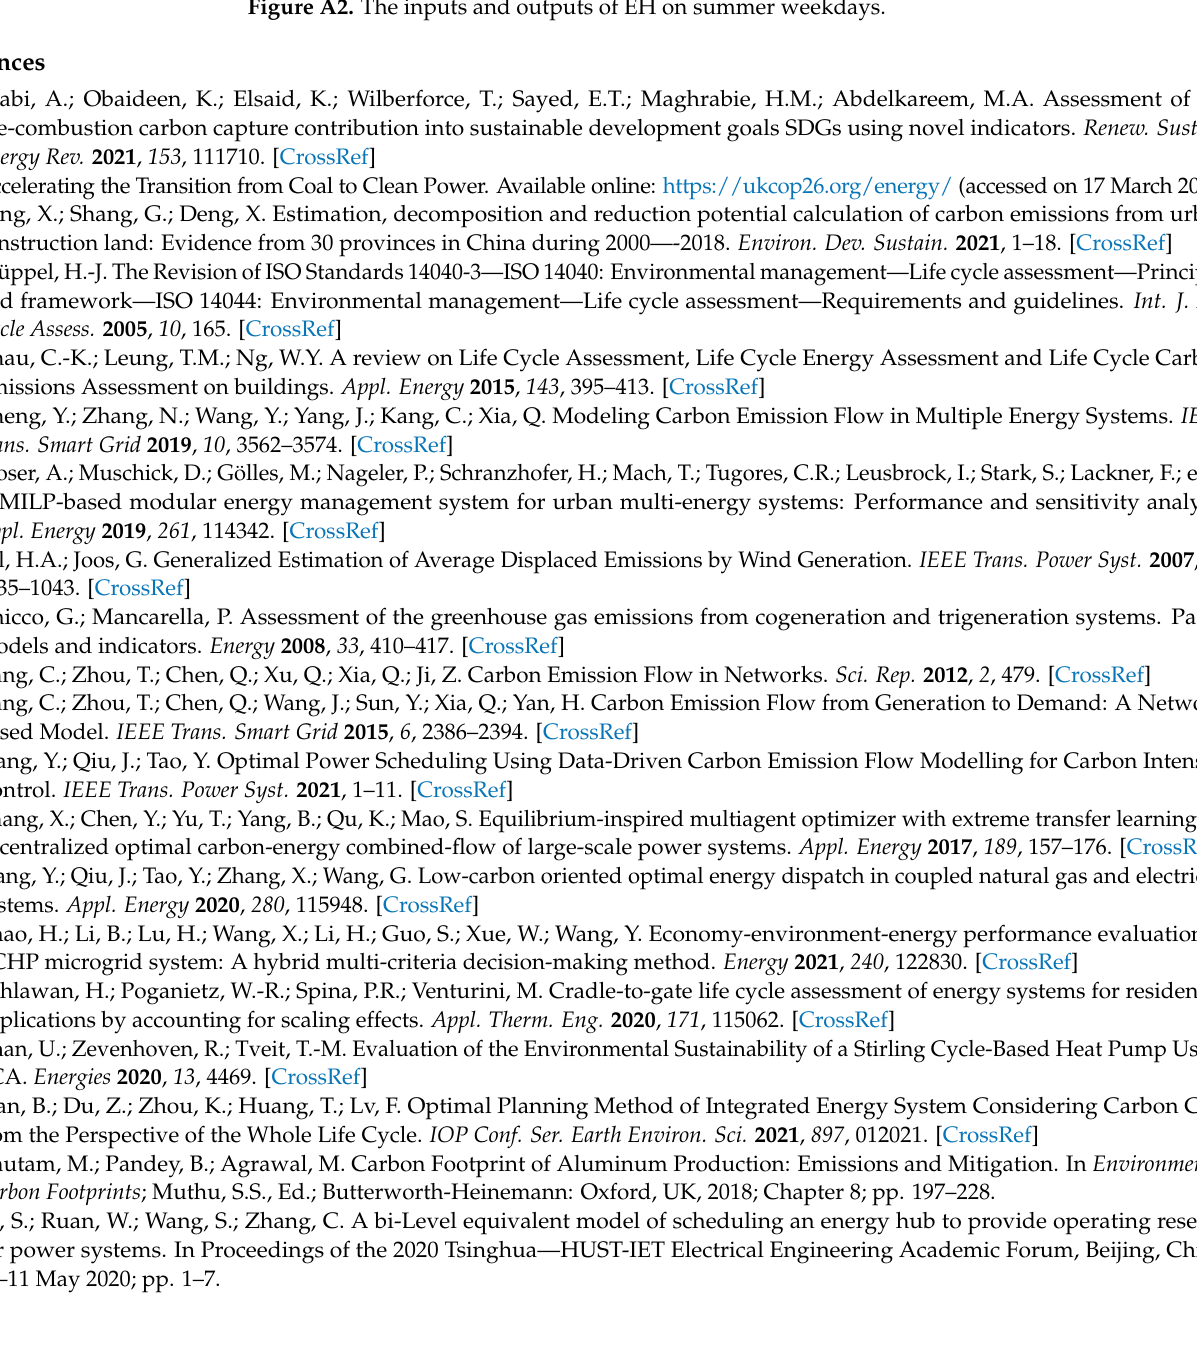
Figure A2. The inputs and outputs of EH on summer weekdays.